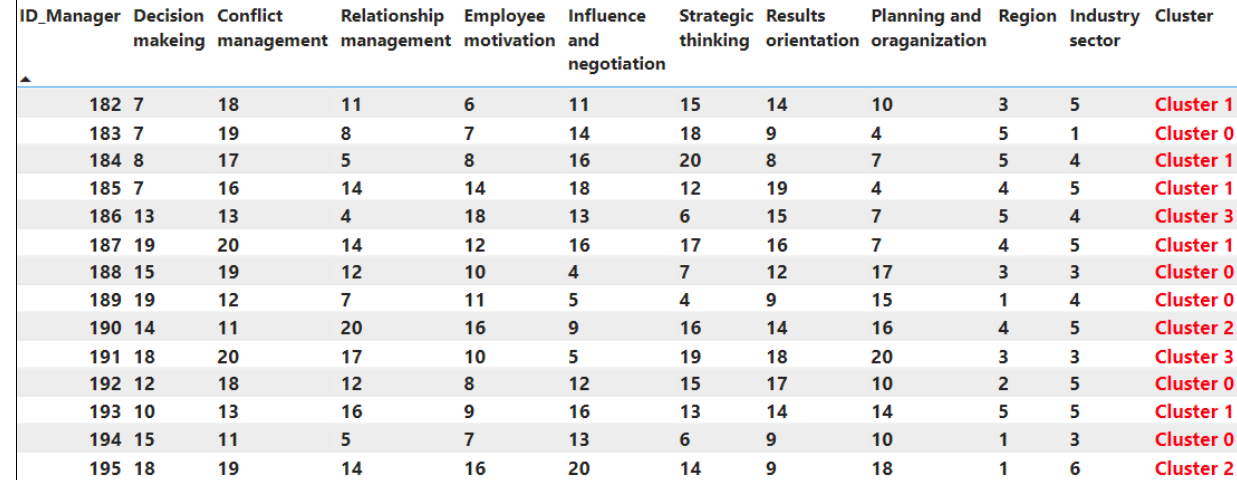
12 of 19 Figure 8. O21. Dataset. Partial data The dataset contained unlabeled data and required further annotation. This was achieved by modelling the data through clustering. PyCaret ’ s clustering module is an unsupervised machine learning module that groups of a set of objects such that those in the same group (called a cluster) are more similar to each other than to those in other groups. Clustering was performed using the K-means algorithm (Script 1, Figure 9).